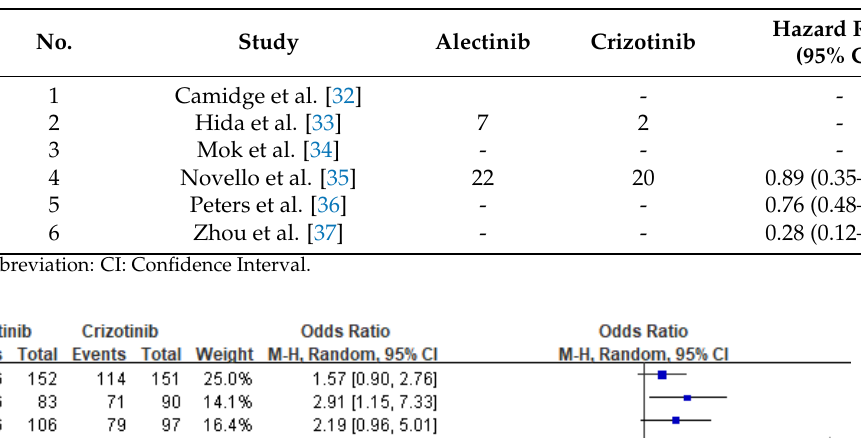
Table 7. Overall Survival. (OS; %).